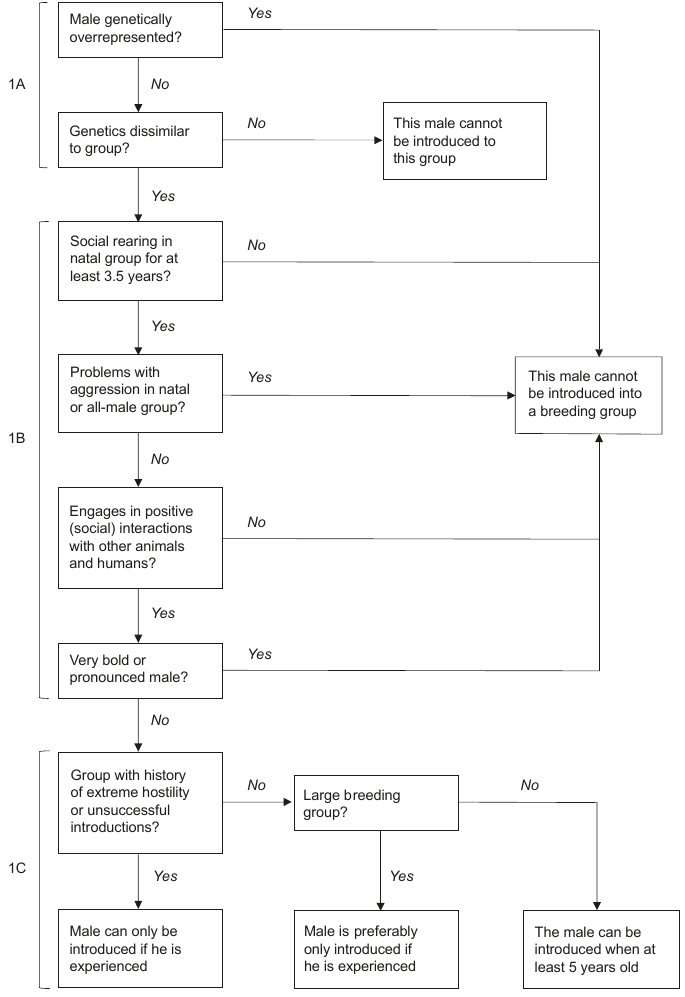
Figure 2. Step 1: The stepwise assessment to determine whether a male can be introduced into a particular group, concerning the new male’s genetic (1A), his social behaviour (1B), and body condition (1C).